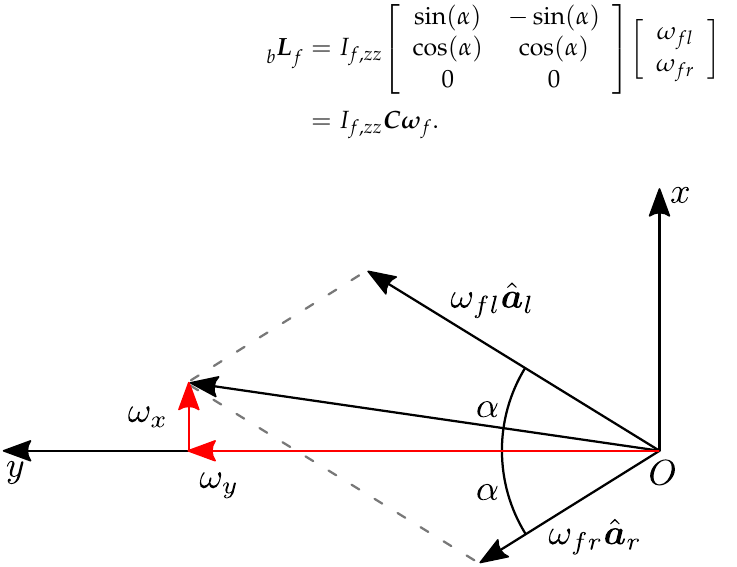
Figure 6. Having incident rotation axes, the OCS allows control of both the robot’s roll and pitch. Notice that the roll angle is influenced by the difference of the angular speeds of the flywheels, (cid:16) (cid:17) ω x = ω fl − ω fr sin ( α ) . On the contrary, the pitch angle depends on the sum of the angular speeds (cid:16) (cid:17) ω y = ω fl + ω fr cos ( α )